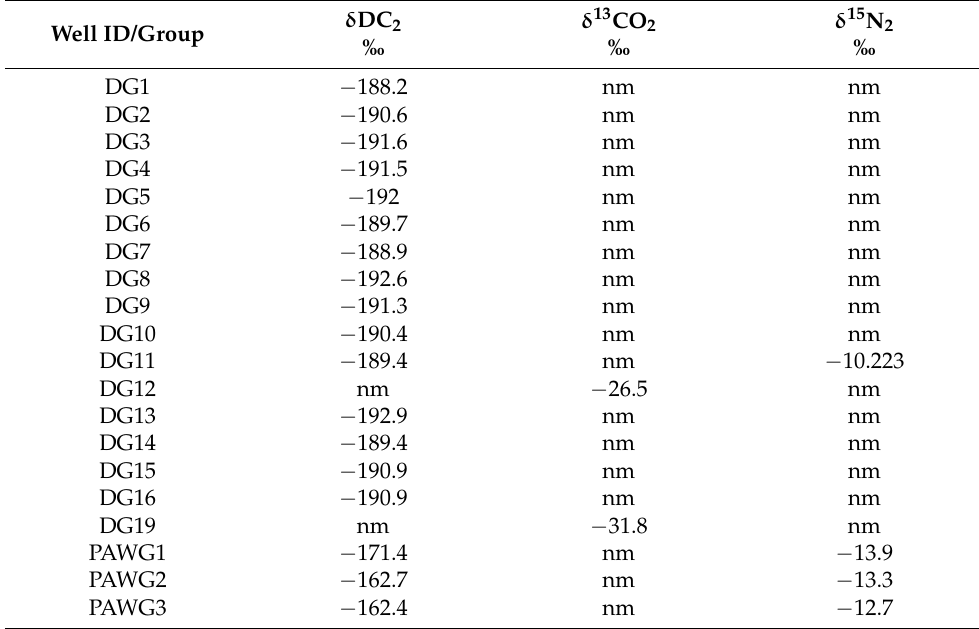
Table 2. Additional isotope ratios for selected samples. nm—not measured.